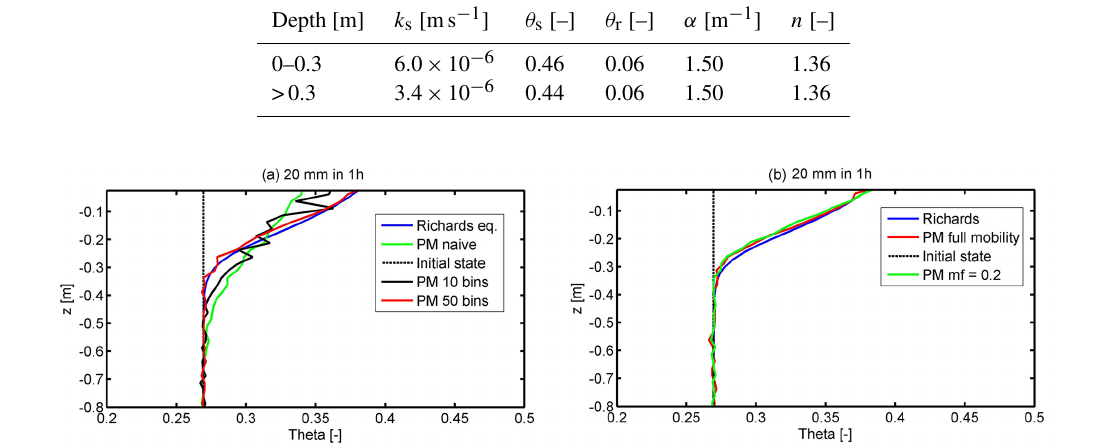
Table 3. Topsoil and the subsoil hydraulic properties at the central meteorological station in the Weiherbach catchment: saturated hydraulic conductivity k s , saturated and residual water contents θ s and θ r , α parameter, and shape parameter n .